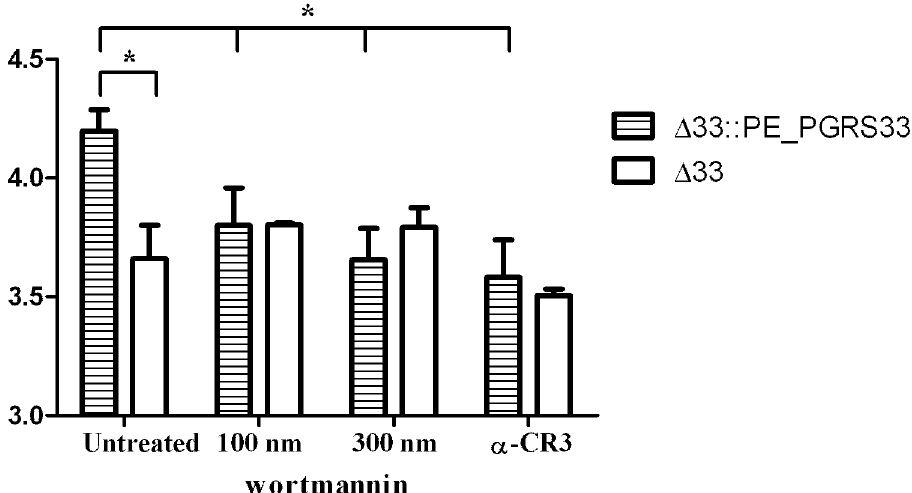
Fig 4. PE_PGRS33 activates the TLR2-dependent pro-adhesive pathway in macrophages. pMM0 isolated from C57Bl/6 mice were incubated with wortmannin or with an anti-CR3 antibody (M1/70), or left untreated, and then infected (MOI 1:10) with Mtb Δ 33 and the complemented strain Mtb Δ 33:: PE_PGRS33 HA and intracellular CFUs were determined at 4h post-infection. Results of one representative experiments of at least three assays are shown ( * p < 0,.001). CFUs were expressed as mean ± SD and were analysed by two-way ANOVA followed by Bonferroni